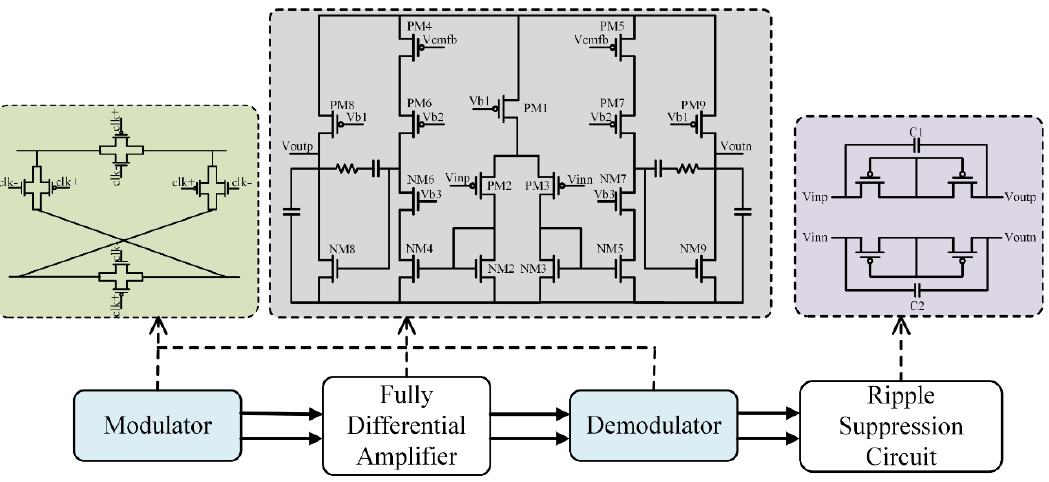
Figure 3. Ripple suppression circuit of the preamplifier.